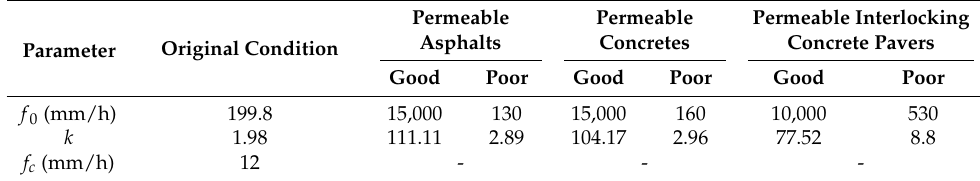
Table 4. Mandatory parameters for all scenarios in model